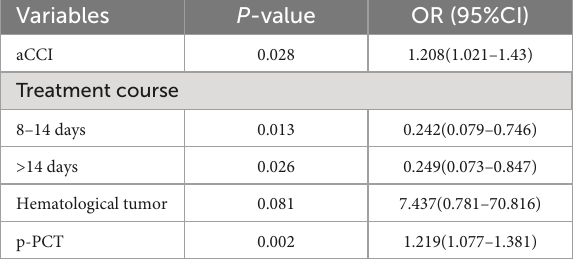
TABLE 4 Multivariate logistic regression of clinical response of polymyxin E sulfate